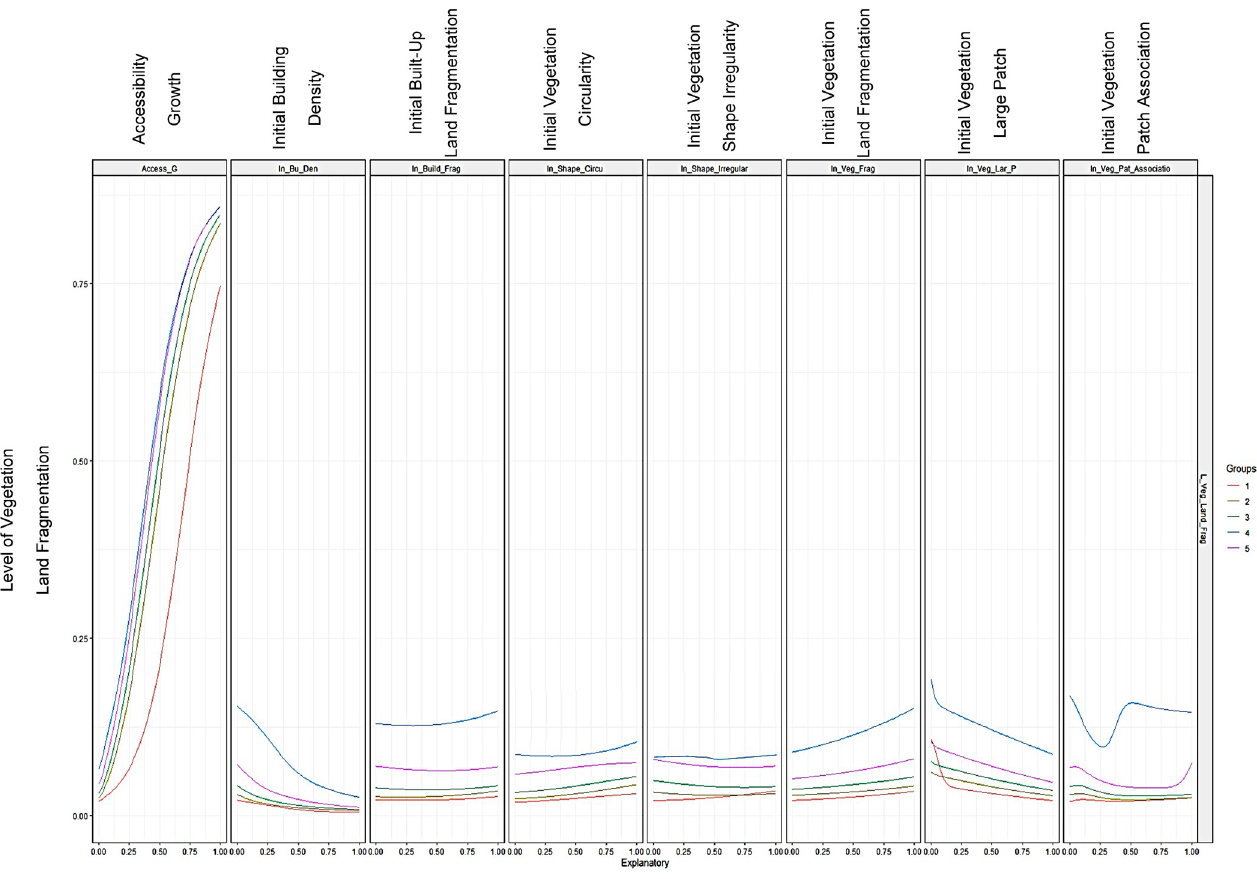
Fig 11. Rules of variables according to lekprofile